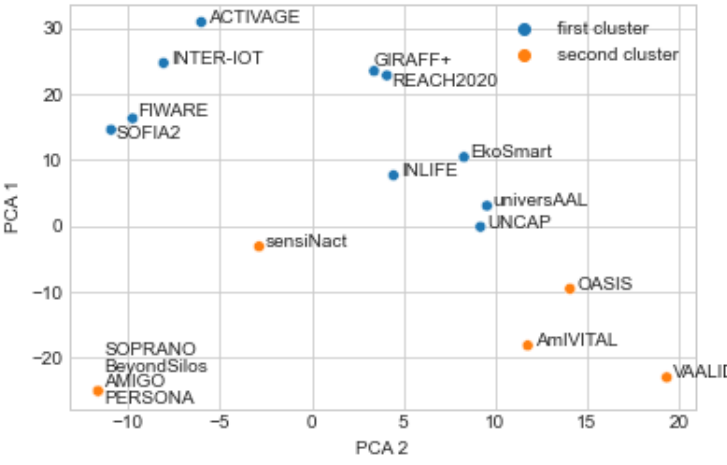
Figure 2. Result of k-means with two clusters and non-standardized input